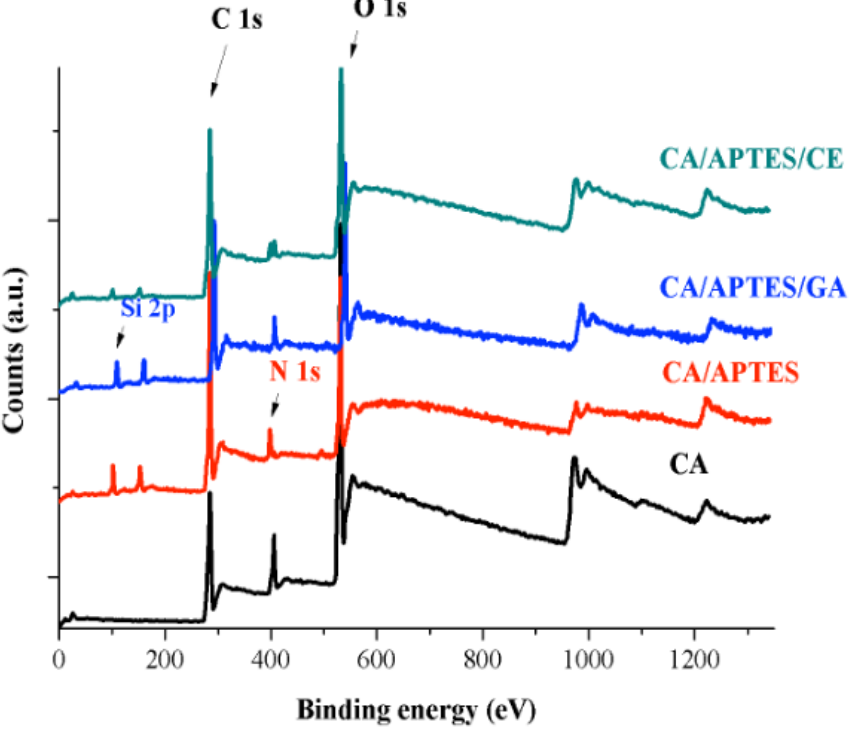
Table 1. XPS atomic percentages obtained for the analyzed samples.